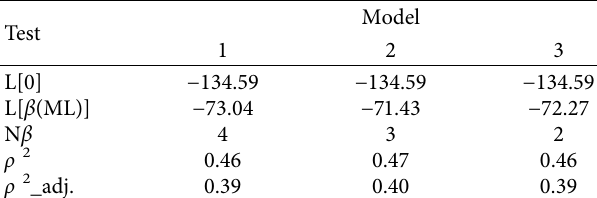
Table 4: Validation tests of the calibrated